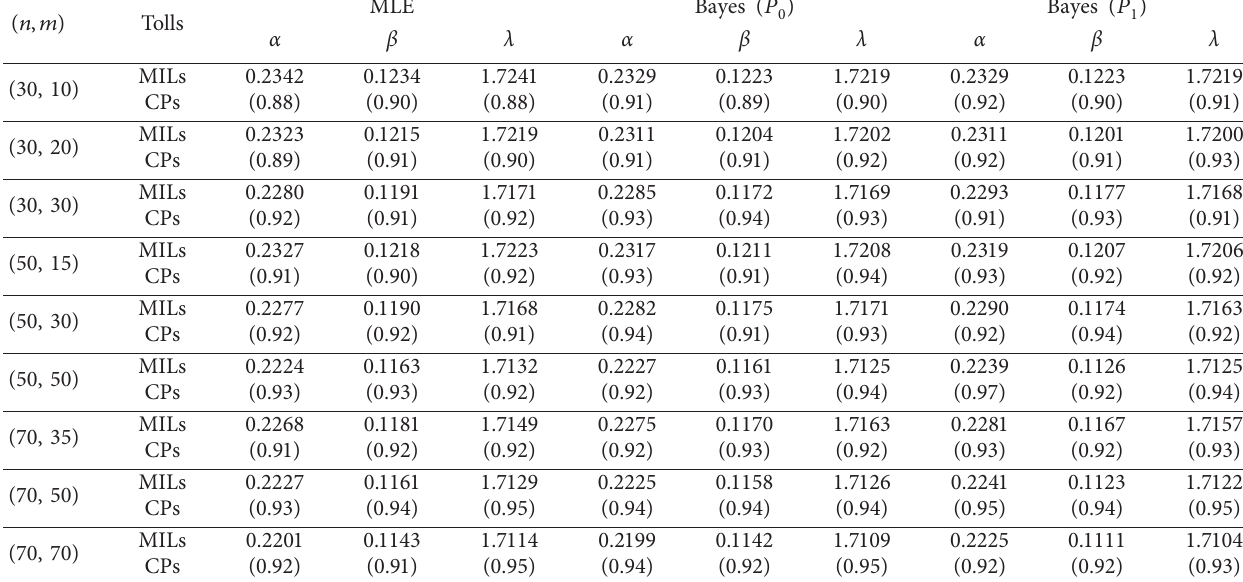
Table 7: MILs and CPs from ω � 0 . 1 , 0 . 05 , 1 . 0 { }